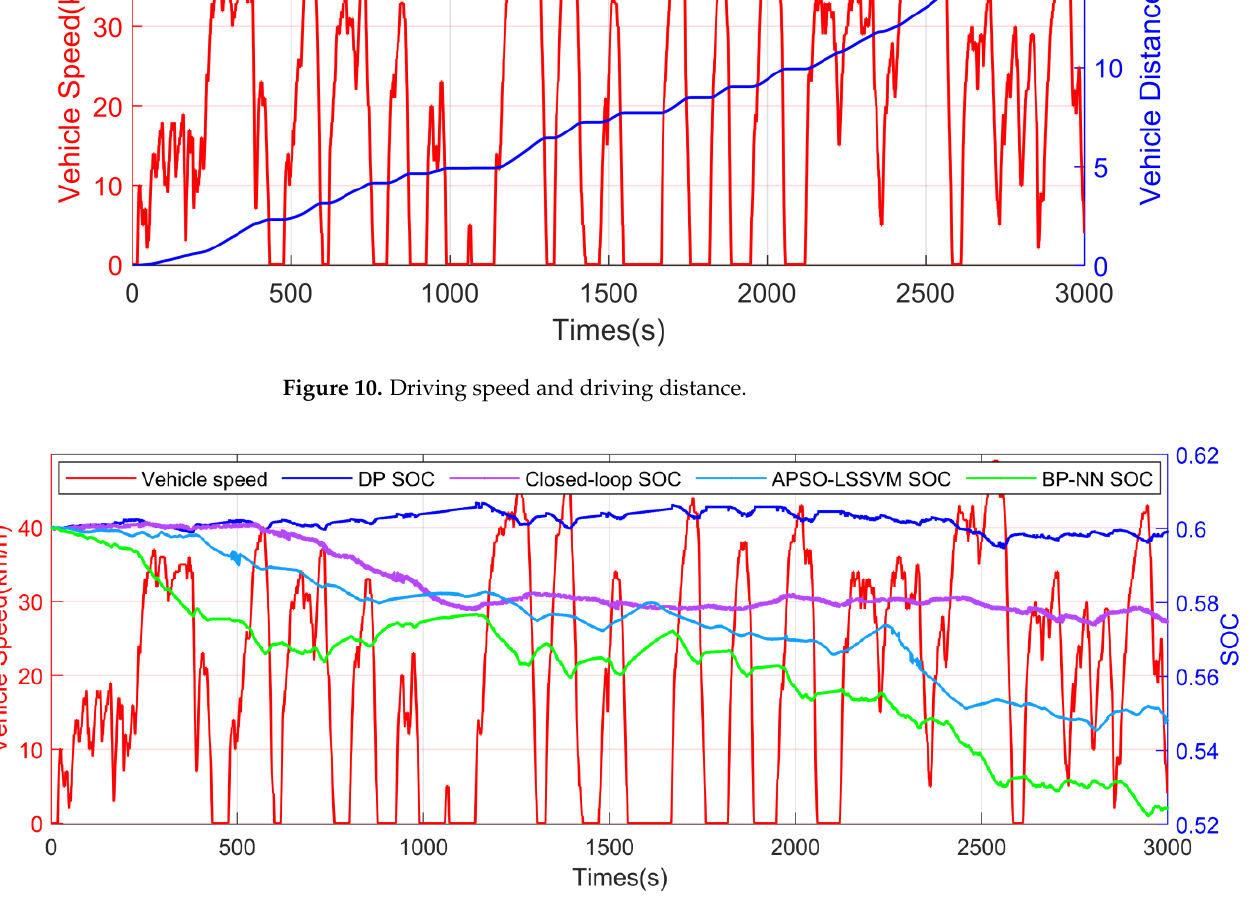
Figure 11. State of charge of SOC with vehicle speed.